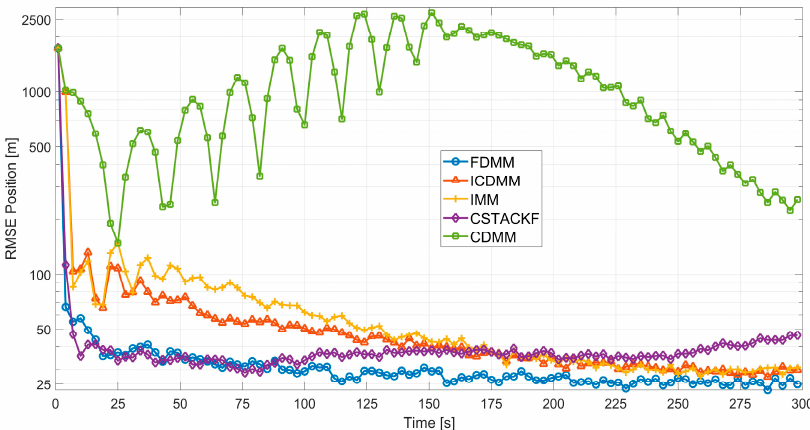
Figure 6. The comparison of position RMSE for different algorithms in Case 1.